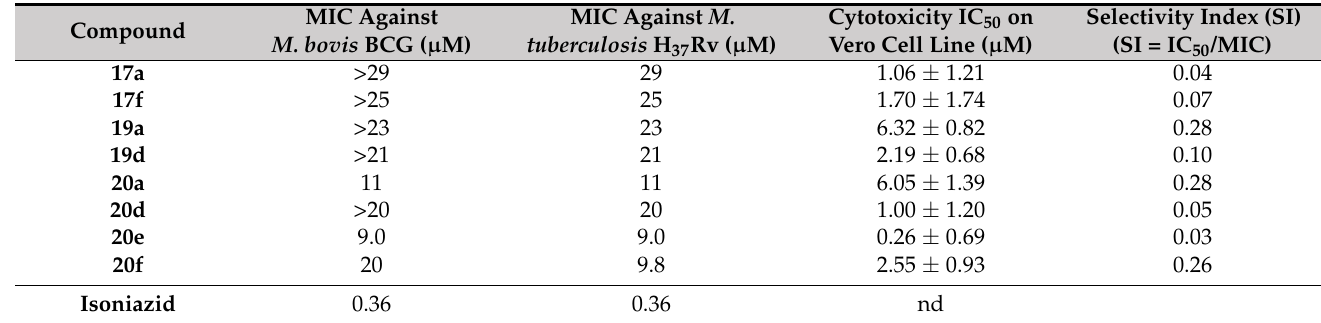
Table 2. Anti-TB and cytotoxic activity for compounds 17a , 17f , 19a , 19d , 20a , 20d-f .